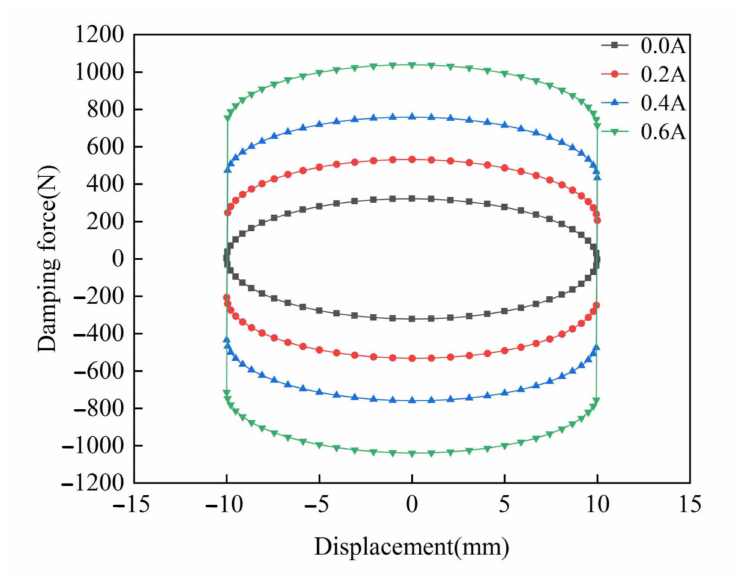
Figure 10. Force-displacement curves under different current simulation